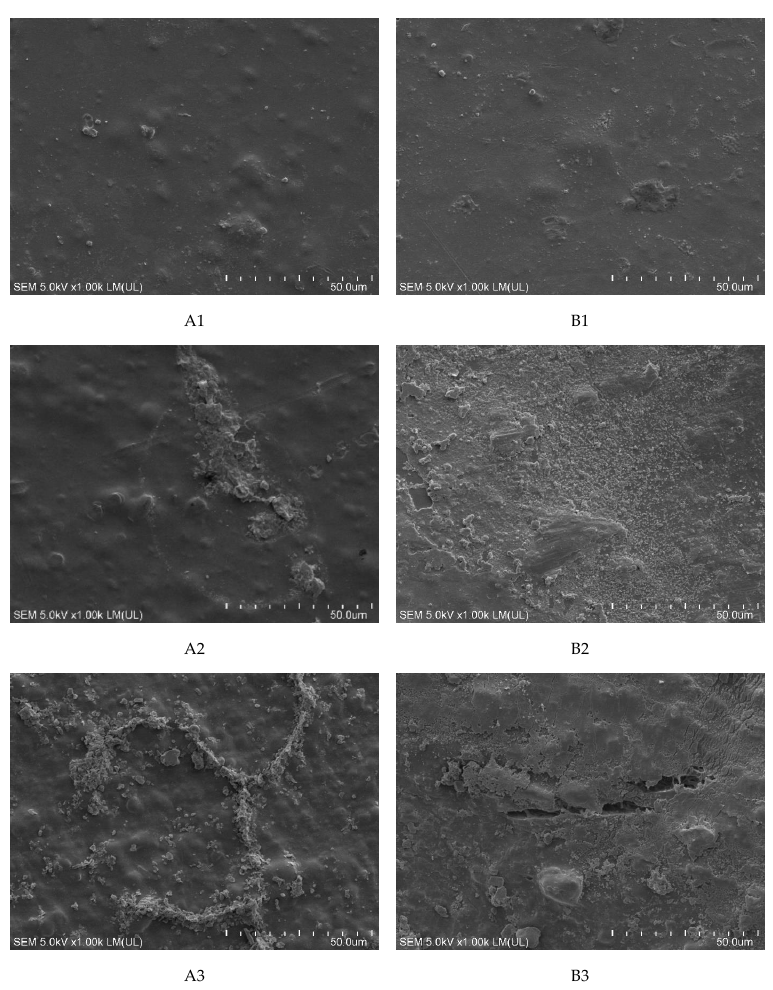
Figure 4. SEM analysis of samples after incubation: ( a ) with fungi and ( b ) with soil. Abbreviations: as in Table 2. Control: sample not subjected to incubation. Based on EDX analysis, the O/C ratio of both elements was calculated. After incuba- tion with fungi, only for samples modified with the highest concentration of talc (A3), a